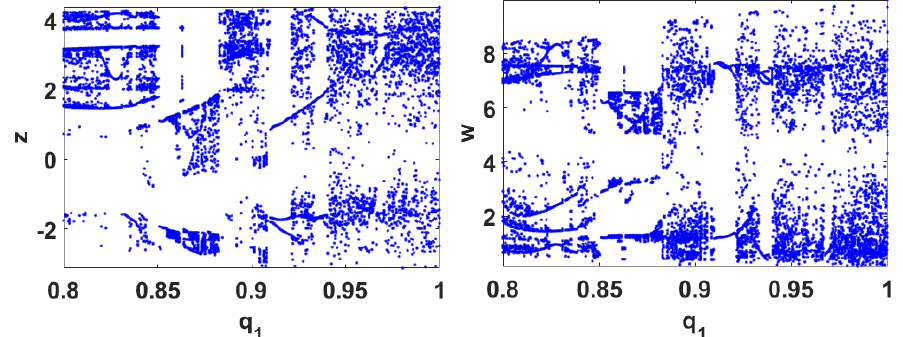
Figure 2. Bifurcations of the fractional memristive system versus q 1 .